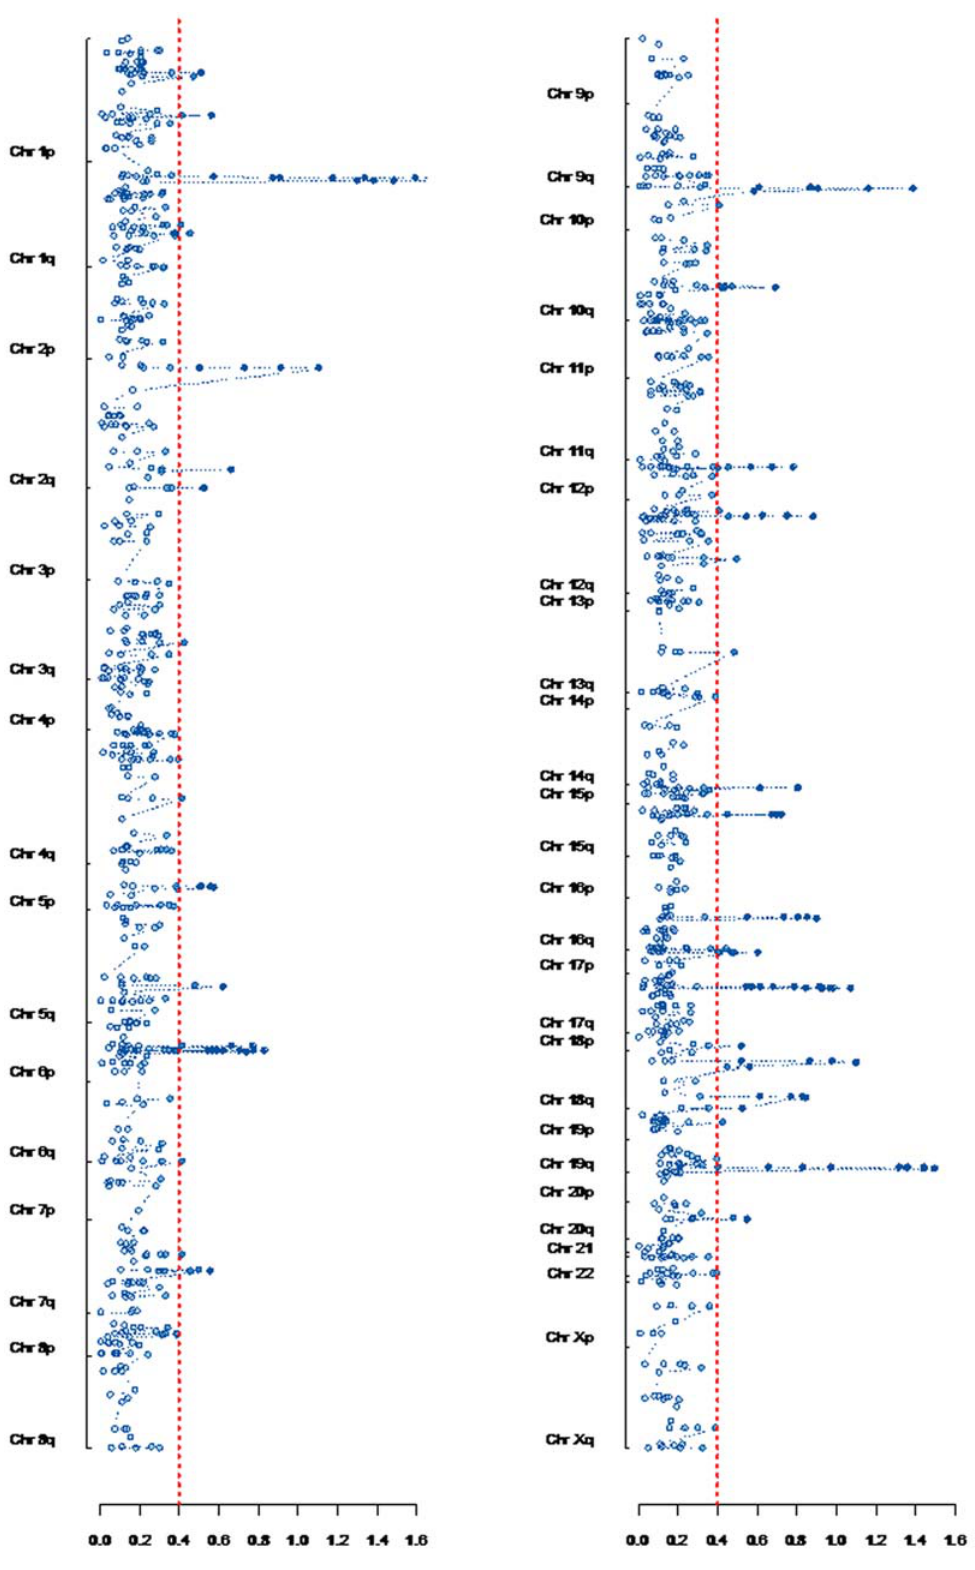
Figure 4. Physical clustering of genes differentially expressed during keratinocyte differentiation. The human genome is depicted in two vertical panels with p and q arms labelled. All probe sets detected as differentially abundant across the time course are displayed at their mapped physical distance within each chromosome and their corresponding Smith-Waterman (SW) score (x axis). The significance threshold corresponding to a FDR of 1 false positive is shown in red. The maximum SW score of 4.1 was detected within the epidermal differentiation complex (EDC) on chromosome 1p21.